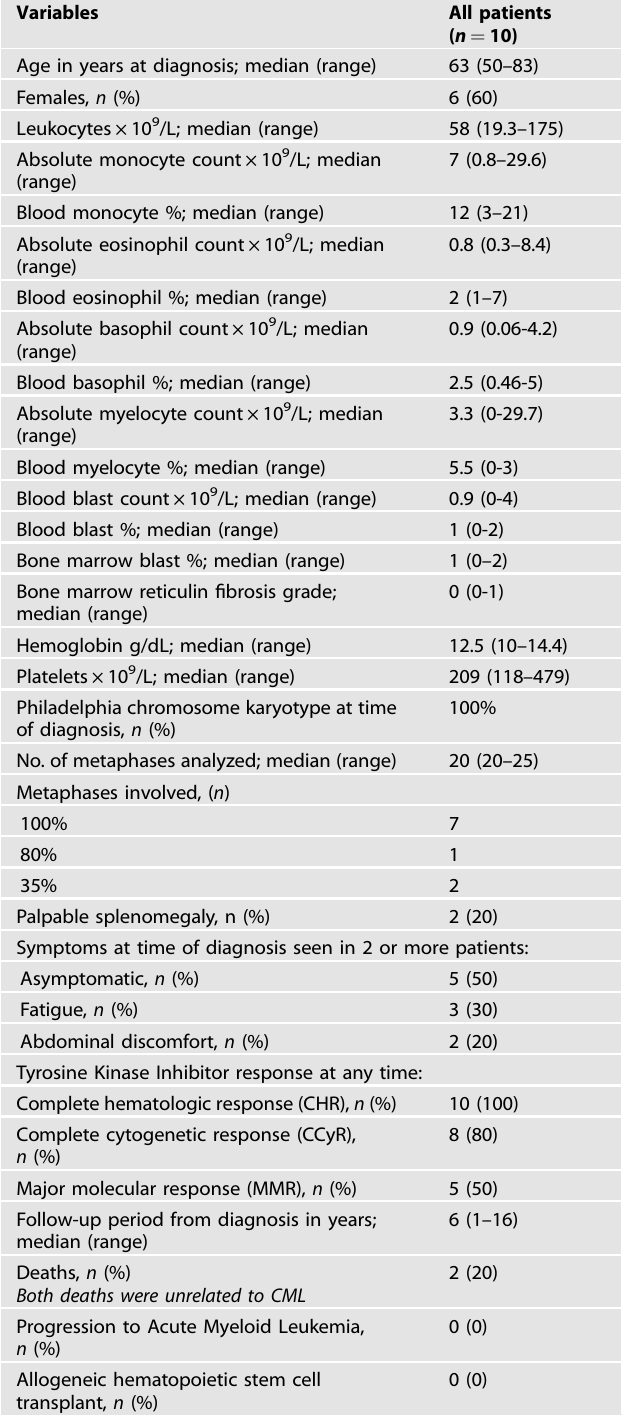
Table 1. Presenting features and clinical course information among ten patients with chronic phase chronic myeloid leukemia (CP-CML) harboring sole BCR::ABL1 e1a2 (P190) transcripts.